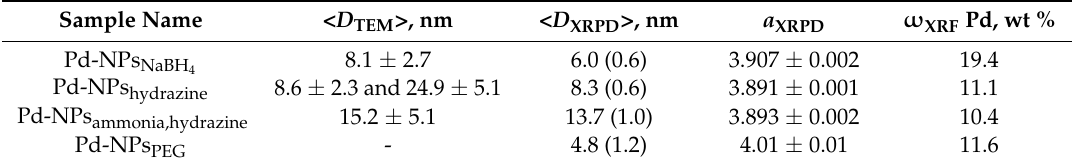
Table 1. Average particle size D TEM obtained by TEM with corresponding size distribution, average crystalline size D XRPD , and lattice parameter a XRPD by X-ray powder diffraction (XRPD), and Pd content ω XRF in wt % determined by X-ray fluorescence (XRF).